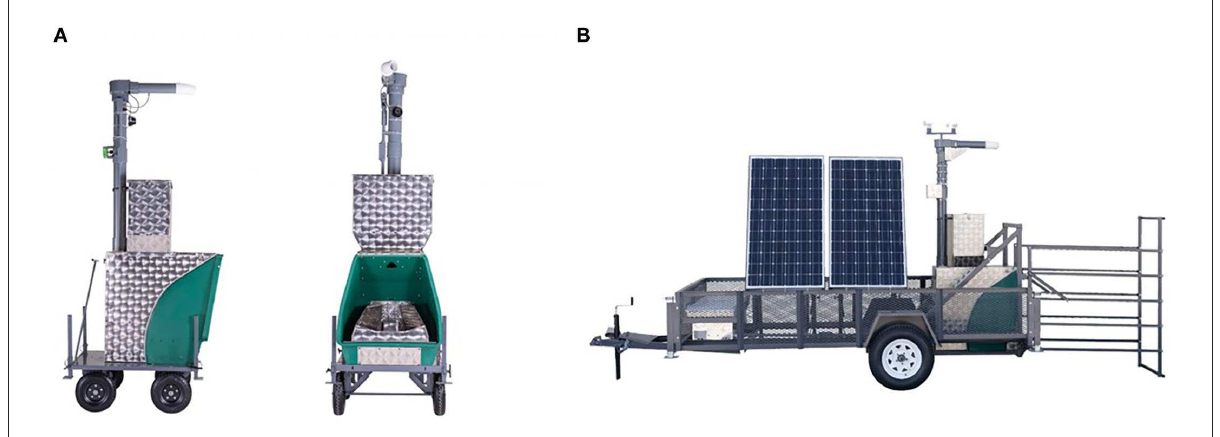
FIGURE2 The Greenfeed Emissions Monitoring (GEM) system for (A) indoor and (B) outdoor use. Image sourced from C-Lock